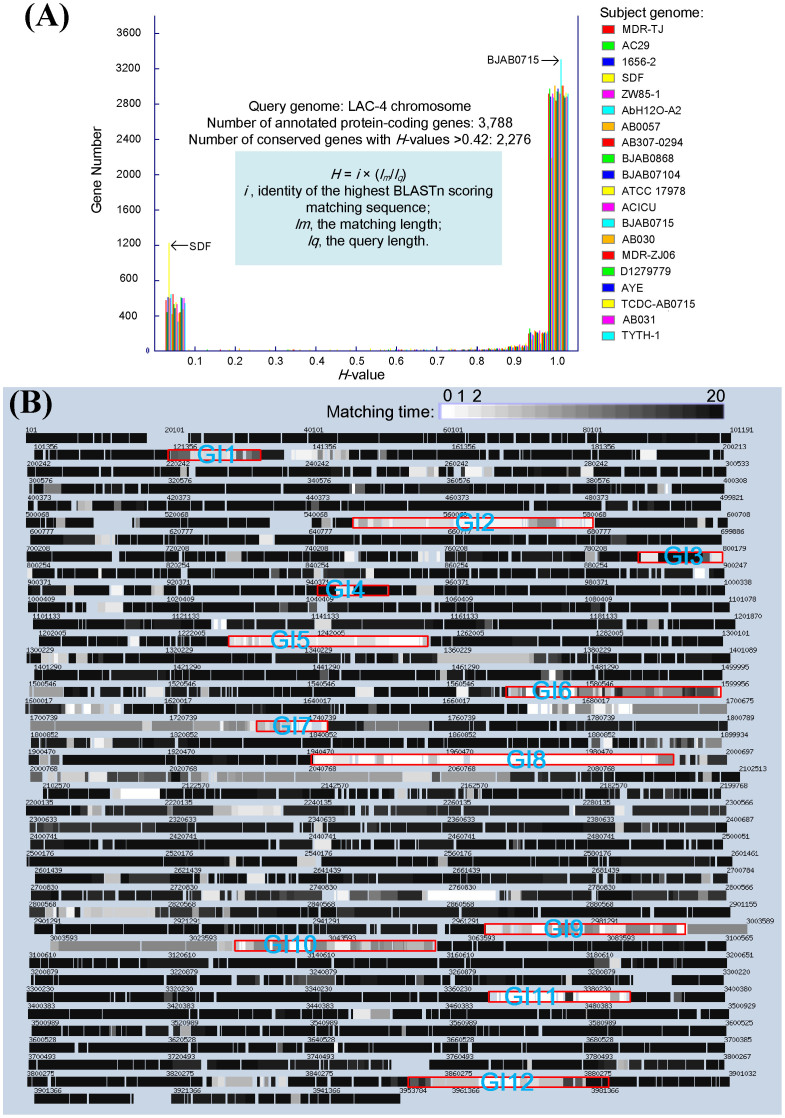
The mGenomeSubtractor-based in silico subtractive hybridization of the LAC-4 genome against genomes of twenty other completely sequenced A. baumannii isolates.The twenty subject A. baumannii chromosomes include: ATCC 17978 (NCBI accession no. NC_009085), SDF (NC_010400), AYE (NC_010410), ACICU (NC_010611), AB0057 (NC_011586), AB307-0294 (NC_011595), 1656-2 (NC_017162), MDR-ZJ06 (NC_017171), TCDC-AB0715 (NC_017387), MDR-TJ (NC_017847), TYTH-1 (NC_018706), D1279779 (NC_020547), BJAB07104 (NC_021726), BJAB0868 (NC_021729), BJAB0715 (NC_021733) and ZW85-1 (NC_023028) available at NCBI RefSeq project; and AB031 (GenBank accession no. CP009256), AC29 (CP007535), AB030 (CP009257) and AbH12O-A2 (CP009534) available at GenBank. (A) Histogram of BLASTn-based H-values for all 3,788 annotated protein-coding genes in the LAC-4 chromosome against all 20 subject chromosome sequences (color-coded). The H-value reflects the degree of similarity in terms of the length of match and the degree of identity at a nucleotide level between the matching gene in the subject genome and the query gene examined. The conserved genes were identified based on each of the obtained H-values great than 0.42. The genome of LAC-4 shows the most significant sequence identity to the BJAB0715 genome with 3,451 conserved genes (H-value > 0.42) among all the other 20 completely sequenced genomes; whereas, the lowest sequence identity to the SDF genome with 2,511 conserved genes (H-value > 0.42). (B) Chromosome map of LAC-4 with gene black/white-shade-coded based on the number of comparator A. baumannii genomes identified as harboring a nucleotide sequence-conserved homologue. Genes shown in absolute black (‘20’) are conserved across all 20 A. baumannii comparator genomes, with genes shown in decreasing shades of black being conserved in lower numbers of A. baumannii comparator genomes, while at the other extreme those shown in white (‘0’) are unique to LAC-4. Non-coding regions are shown as gaps. The genomic island-like hyper-variable regions (also see Table 3) are marked by red rectangles.